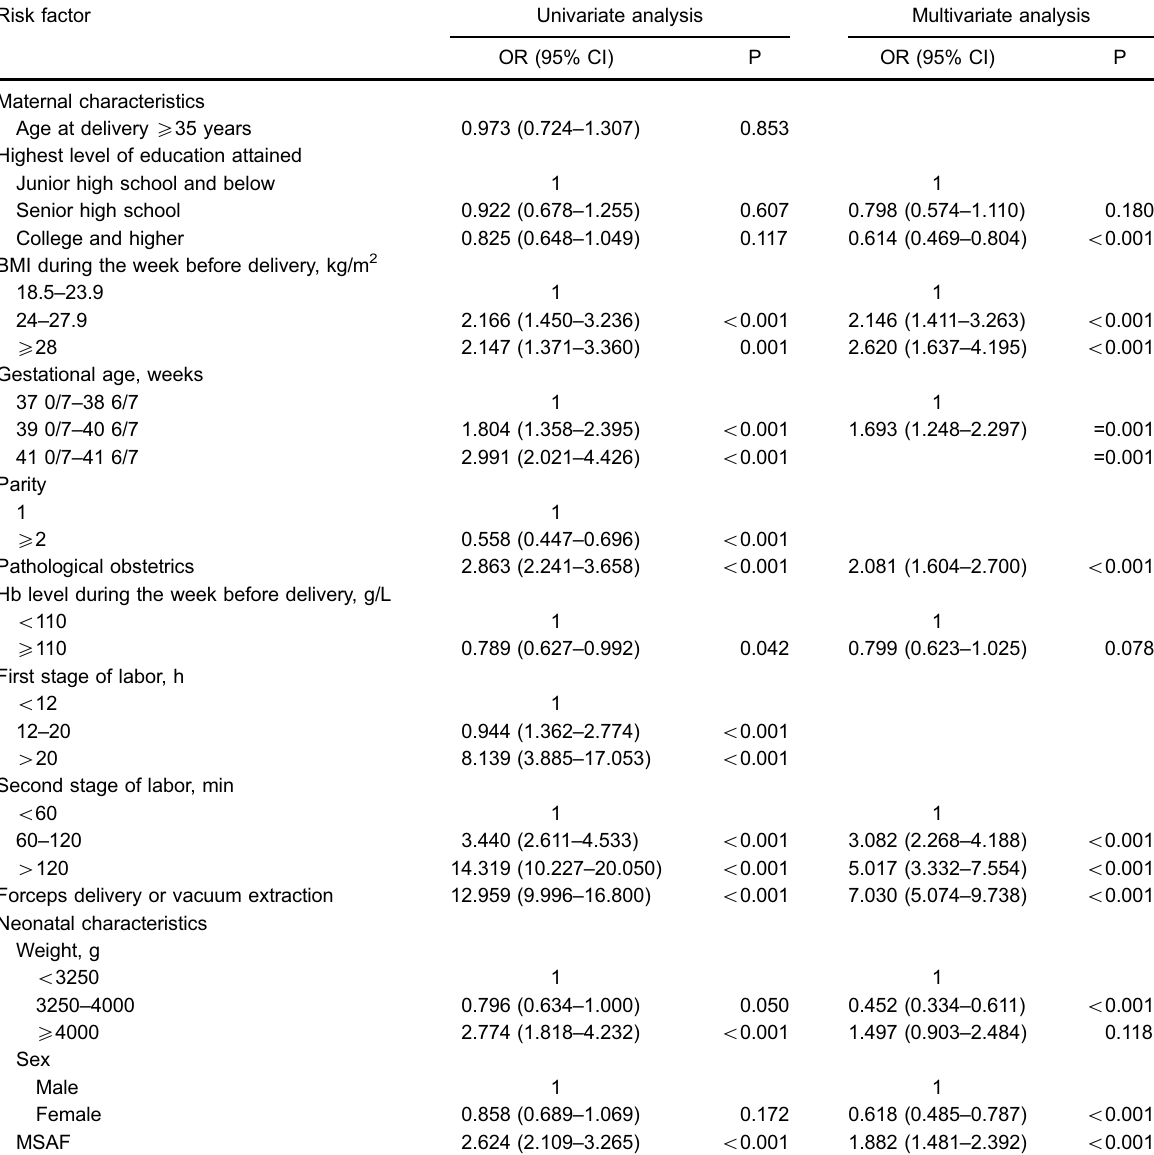
Table 3. Univariate and multivariate analyses of risk factors for low 1-min Apgar scores ( o 7) in single-gestation neonates born vaginally from 37 weeks 0 days to 41 weeks 6